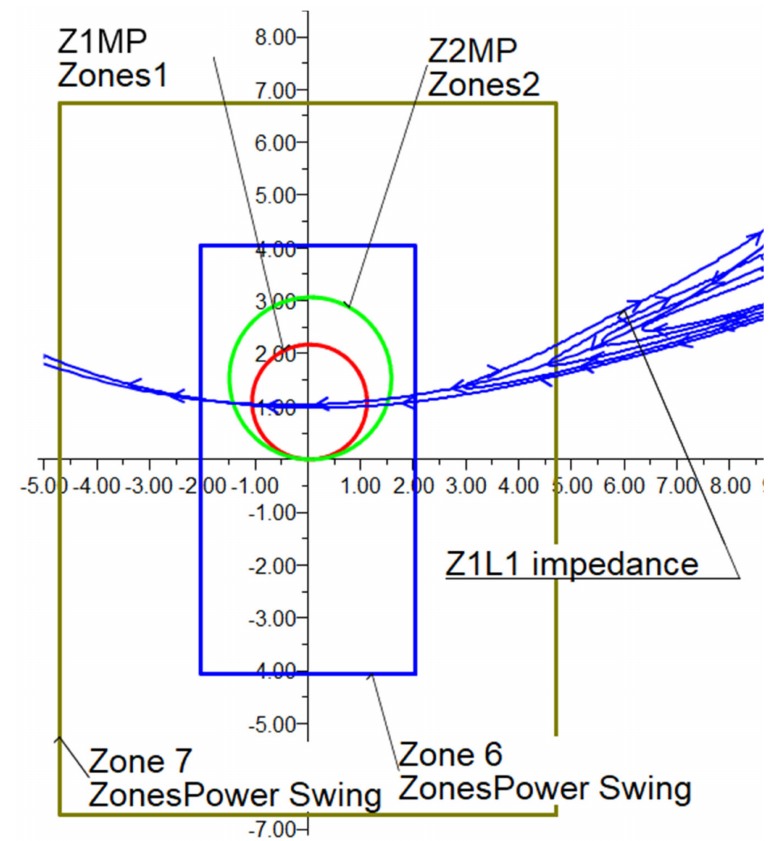
Figure 17. Test 1 : R-X plot with OOS protection on CCT-1 line.